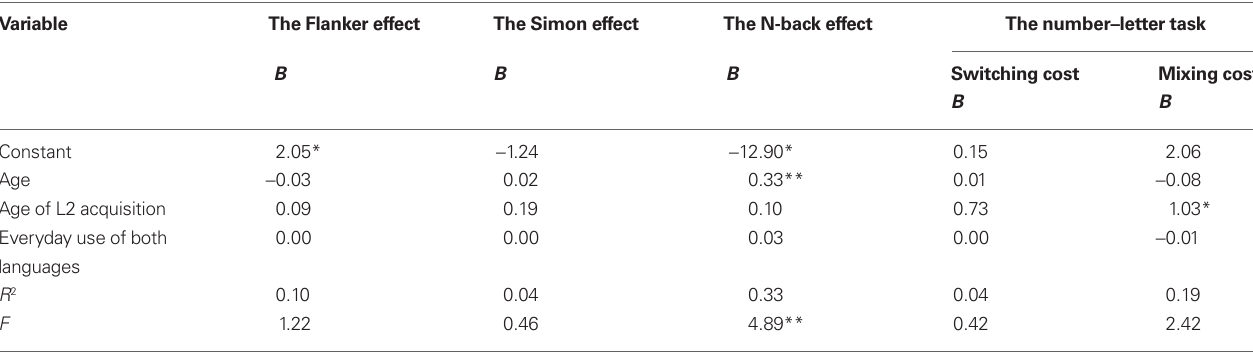
Table 5 | Summary of the multiple regression analyses: background variables as predictors of processing cost in errors on the executive tasks.